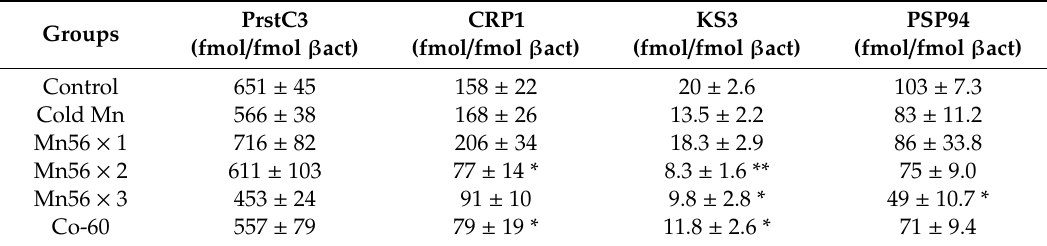
Table 2. mRNA levels of secretory protein genes in the